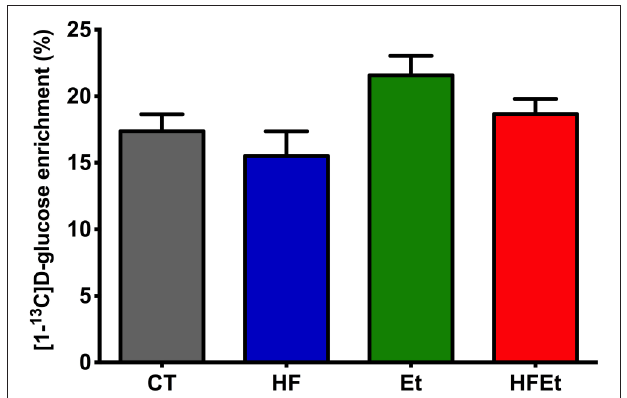
FIGURE 3 | Specific enrichment of glucose 13 C (% 13 C) obtained in the brain following 1h of [1- 13 C]D-glucose infusion in rats fed with control (CT), high fructose (HF), ethanol (Et), or a mix diet (HFEt). Specific enrichments were normalized to the Glucose C1 specific enrichment in each group.